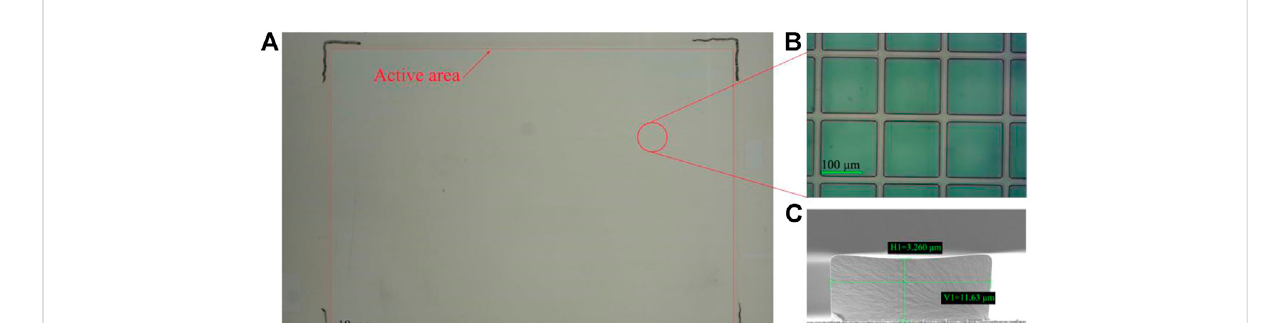
respectively. Structures on the bottom substrate are shown in Figure 5.